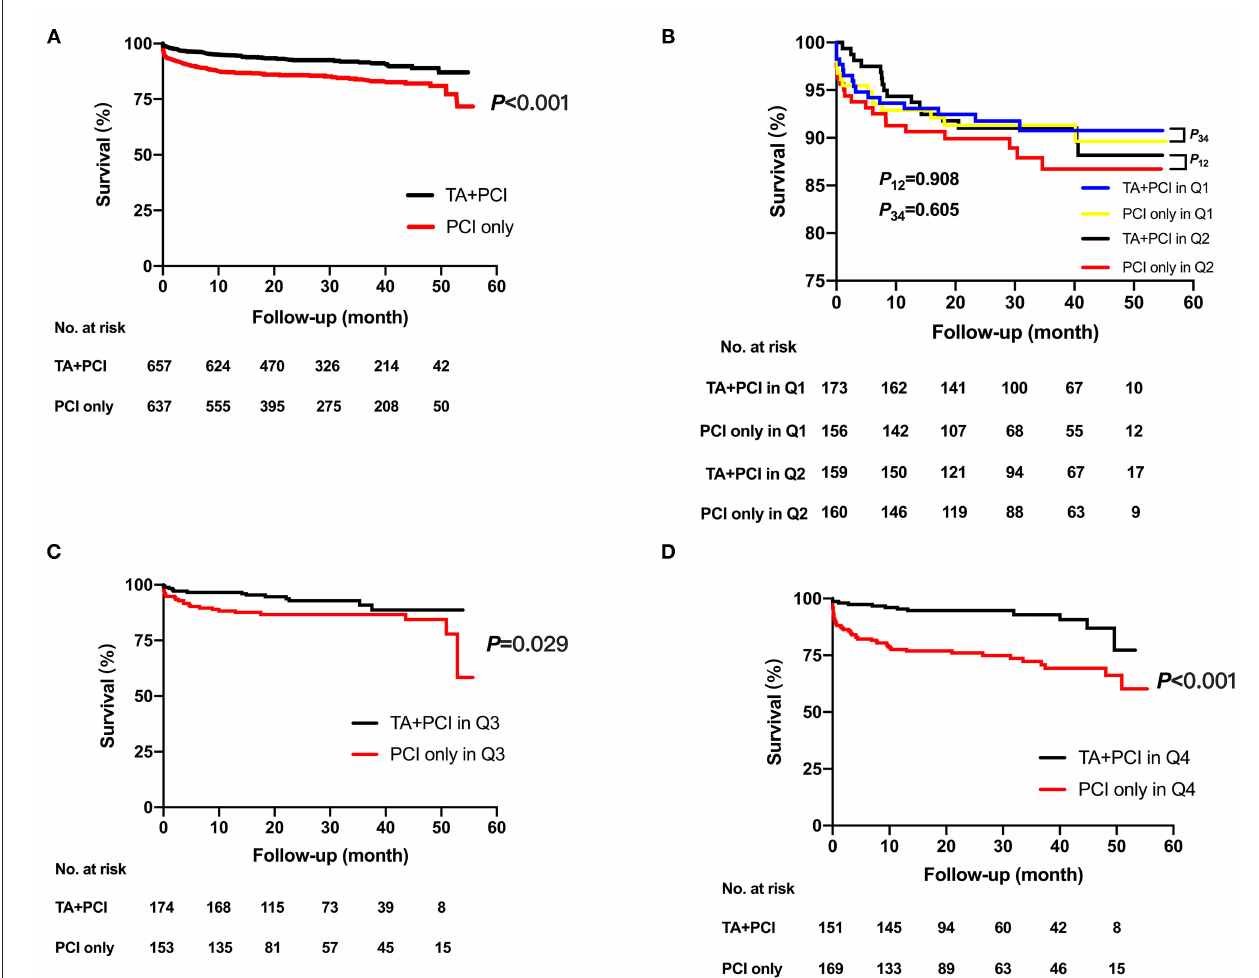
FIGURE 1 | Kaplan–Meier time-to-event curves for all-cause death for the total duration of follow-up after the intervention. Kaplan–Meier estimates in TA + PCI group (red curve) and PCI-only group (black curve) for the rate of all-cause mortality in the whole population (A) and all-cause mortality of TA + PCI group (blue curve) and PCI-only group (yellow curve) in quartile 1; all-cause mortality of TA + PCI group (black curve) and PCI-only group (red curve) in quartile 2 (B) ; all-cause mortality of TA + PCI group (black curve) and PCI-only group (red curve) in quartile 3 (C) ; and all-cause mortality of TA + PCI group (black curve) and PCI-only group (red curve) in quartile 4 (D) . TA, thrombus aspiration; PCI, percutaneous coronary intervention; P 12, p -value between the TA + PCI and PCI-only in group Quartile 1; P 34, p -value between the TA + PCI and PCI-only in group Quartile